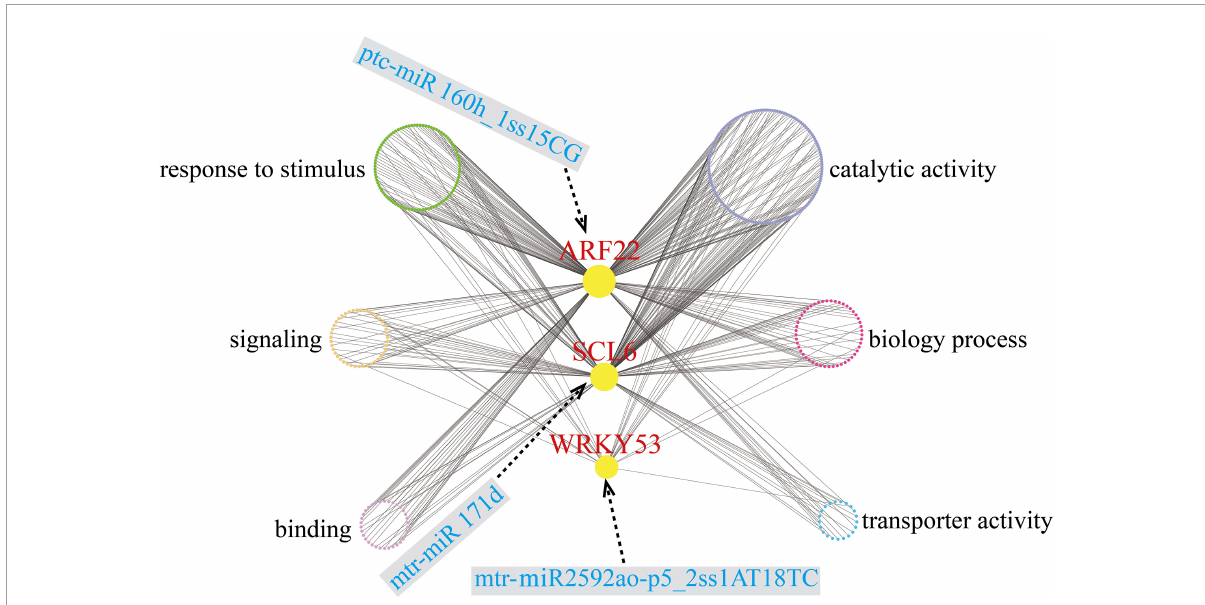
FIGURE7 Co-expression subnetwork of ARF22 , WRKY53 , and SCL6 . Red-colored letter denotes key hub gene; blue-colored letter denotes key miRNA; six different colored circles represent six different categories.